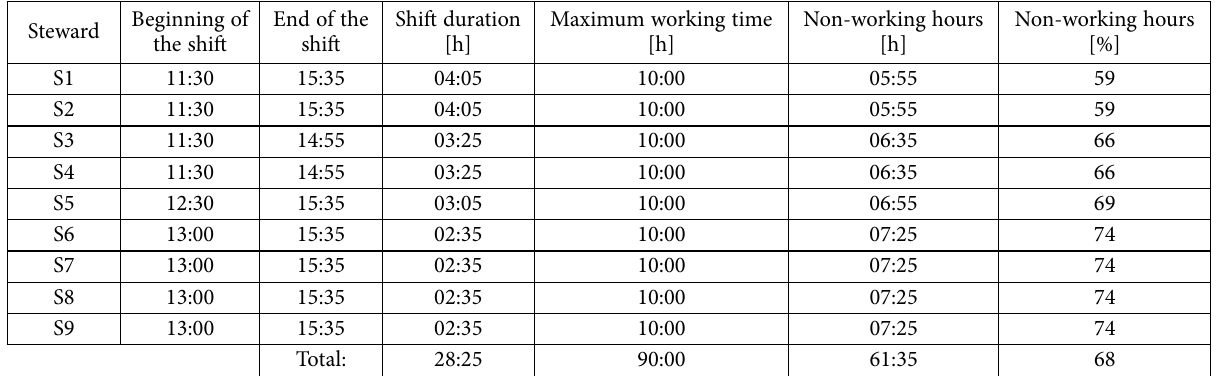
Table 5. Numerical results for instance of 2 flights